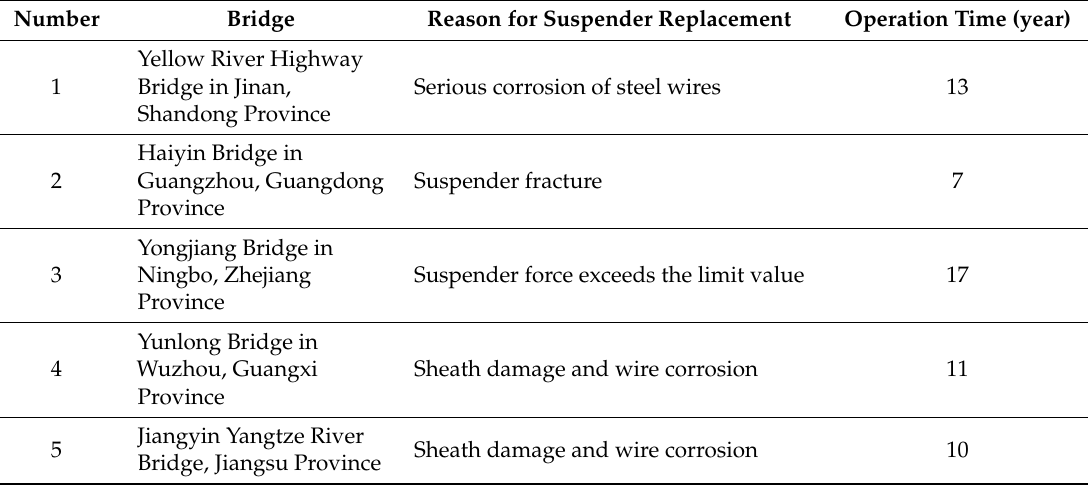
Figure 1. Kongque River Bridge damaged in 2011. Table 1. Some famous suspender replacement projects in China.